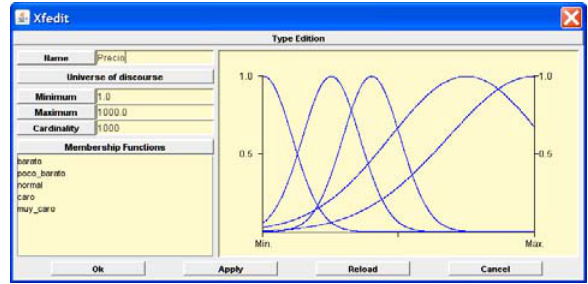
Fig. 6: Variable ‘initial_price’ and its corresponding fuzzy sets